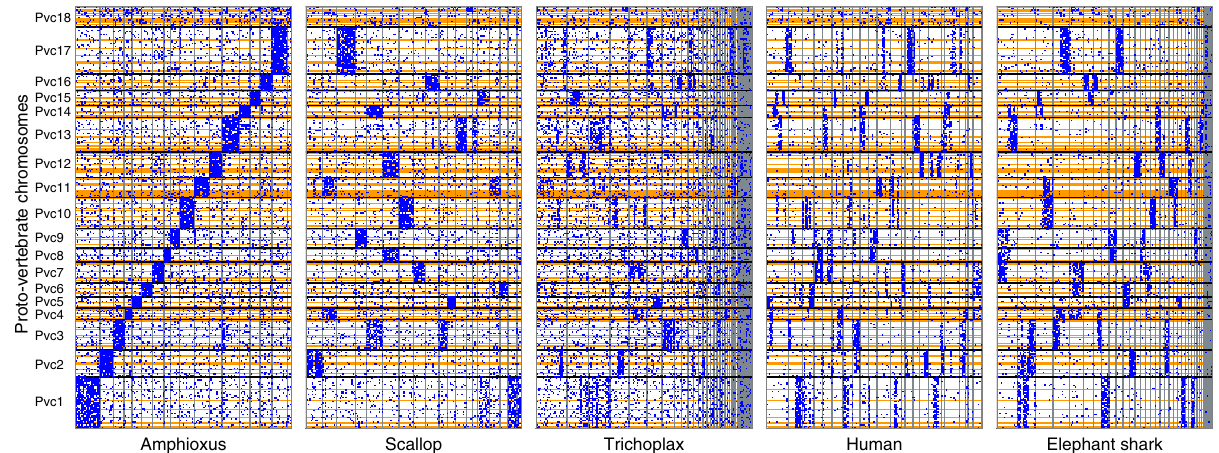
Fig. 2 Each of the reconstructed proto-vertebrate chromosomes exhibits a distinct orthologue distribution in invertebrate and gnathostome genomes. The reconstructed proto-vertebrate chromosomes, as represented by the Japanese lamprey segments ( y -axis), were compared with the amphioxus, scallop, Trichoplax , humans, and elephant shark genomes ( x -axes), and their orthologues are plotted (blue dots). The proto-vertebrate chromosomes (Pvc1 – Pvc18) are shown from bottom to top along the y -axis, and their boundaries are indicated by horizontal black lines. The boundaries of Japanese lamprey segments are indicated by the horizontal orange lines. The amphioxus scaffolds are organized into 18 groups representing the proto-vertebrate chromosomes. The scallop chromosomes are shown from chr1 to chr19. The Trichoplax and elephant shark scaffolds were sorted by the number of genes and the largest 50 scaffolds are shown. Human chromosomes are shown from chr1 to chrY.